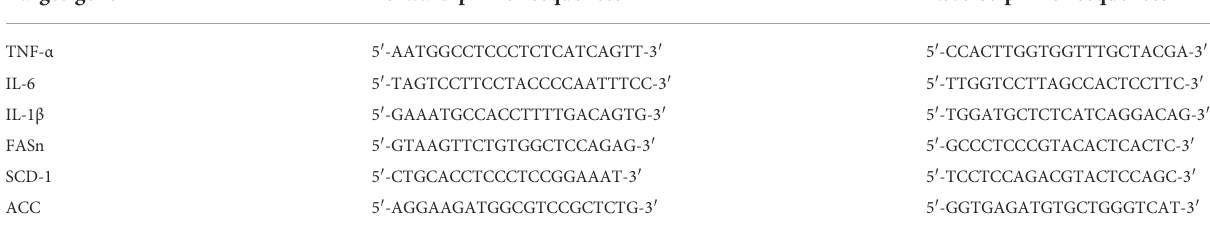
TABLE 1 Primers sequences for quantitative real-time